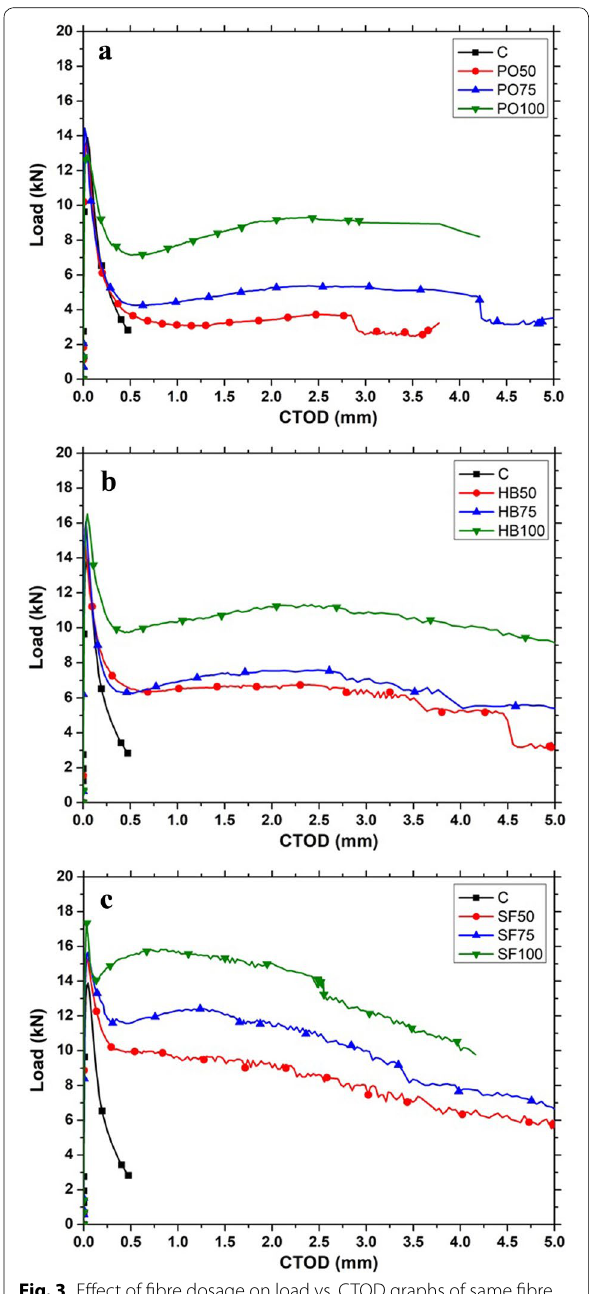
Fig. 3 Effect of fibre dosage on load vs. CTOD graphs of same fibre type: a SynFRC; b hybrid; c